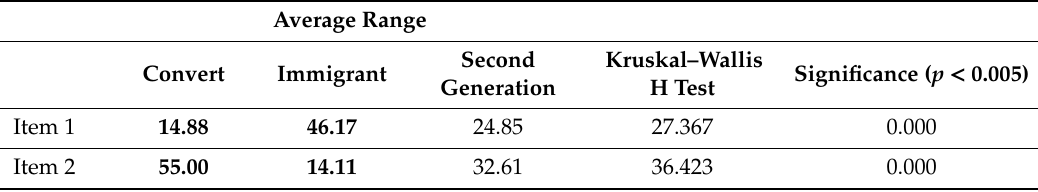
Table 3. Results of the Kruskal–Wallis H